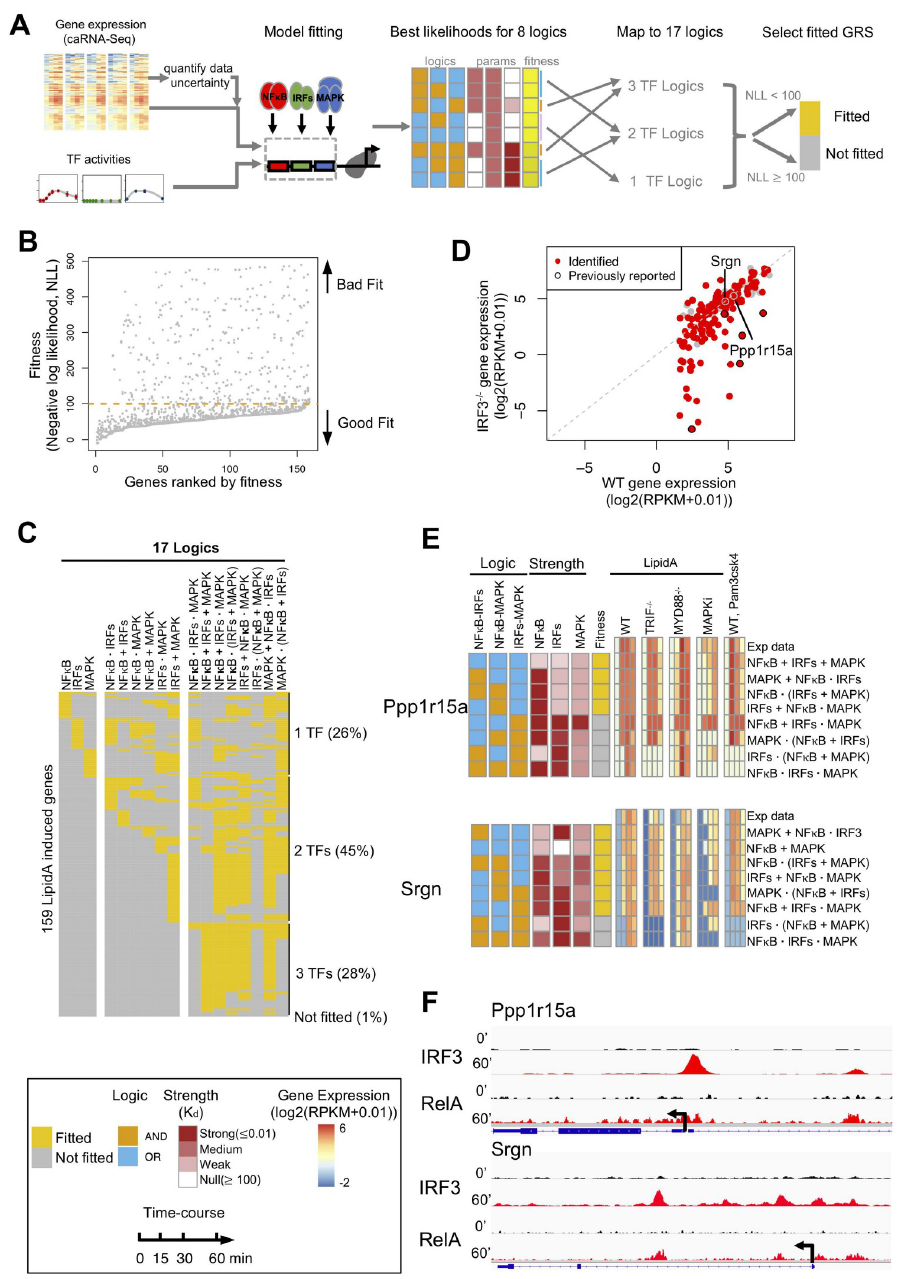
Fig 6. Mapping GRSs involving NF κ B, IRFs, MAPK to endotoxin-induced immune genes. (A) Scheme of fitting models to experimental data. Gene expression data and TF activities for different stimuli were used to fit 8 possible model topologies and best likelihoods are determined; this was followed by mapping to 17 possible logics (Fig 1D), which were then determined to whether they fit the data, or not. (B) The plot of fitness (negative log likelihood) of 8 triple TF logic gates for all lipid A-induced genes identified by [19]. An arbitrary threshold to select fitted logic gates is marked as an orange dashed line. (C) The plot of fitted GRS logic gates for lipid A-induced genes identified by [19]. Only 26% of these genes fit a GRS governed by a single TF; most require GRS models that are controlled by at least two. (D) Peak expression of IRF3 -/- is assessed against WT peak expression for all the lipid A-induced genes. Genes that are identified as potentially synergistically regulated by NF κ B and IRFs are marked in red. The 5 previously reported IRF3-NF κ B-regulated genes [19] are marked with a black circle. (E) For two example genes, heatmaps of experimentally measured caRNA-seq time-course data and simulation data by the best-fit GRS models, ordered by fit quality from top (best) to bottom. (F) IGV genome browser tracks of IRF3 and RelA ChIP-seq data in resting and 60 min lipid A-stimulated macrophages of the two